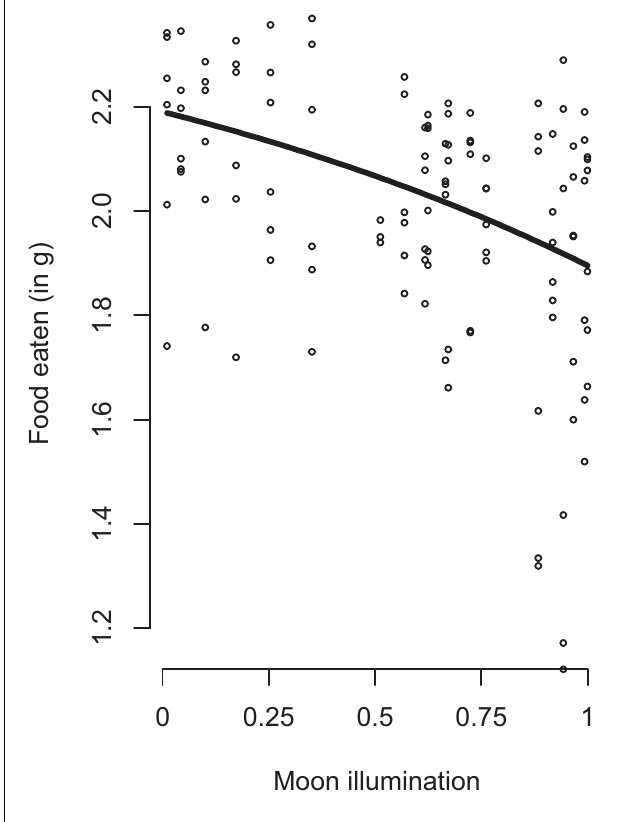
FIGURE 2 | The effect of relative moon illumination (black line; 0 at new moon, 1 at full moon) on the amount of food eaten by free-living white-footed mice. 95% Confidence interval shown as gray area. Dots represent datapoints. Moon illumination was based on date of data collection and accessed through the R package